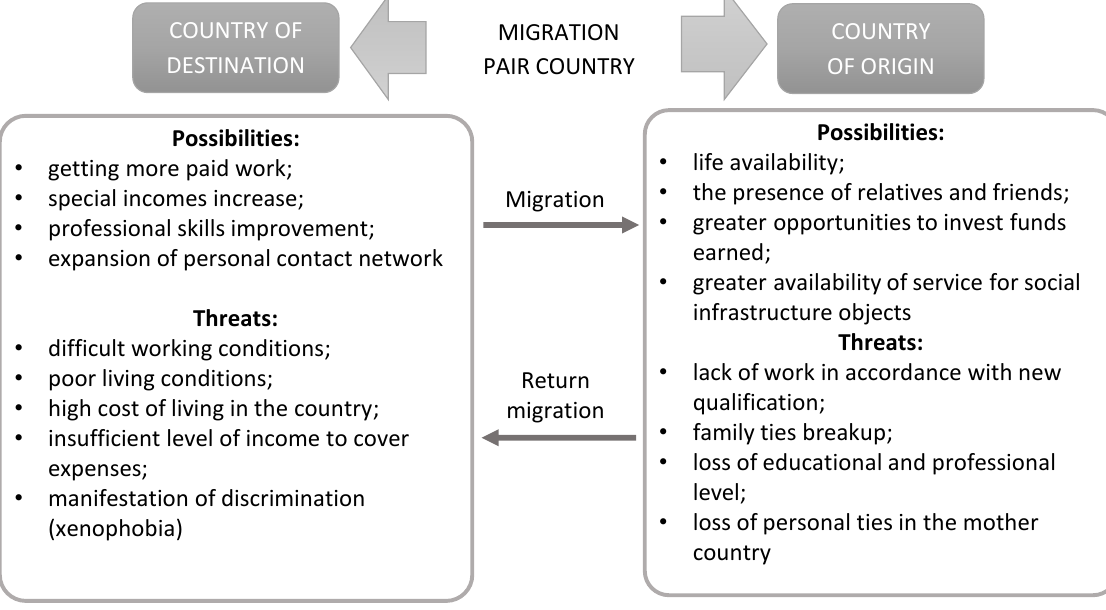
Figure 2. Personal “pulling-pushing” factors of migration motives and motives of return home